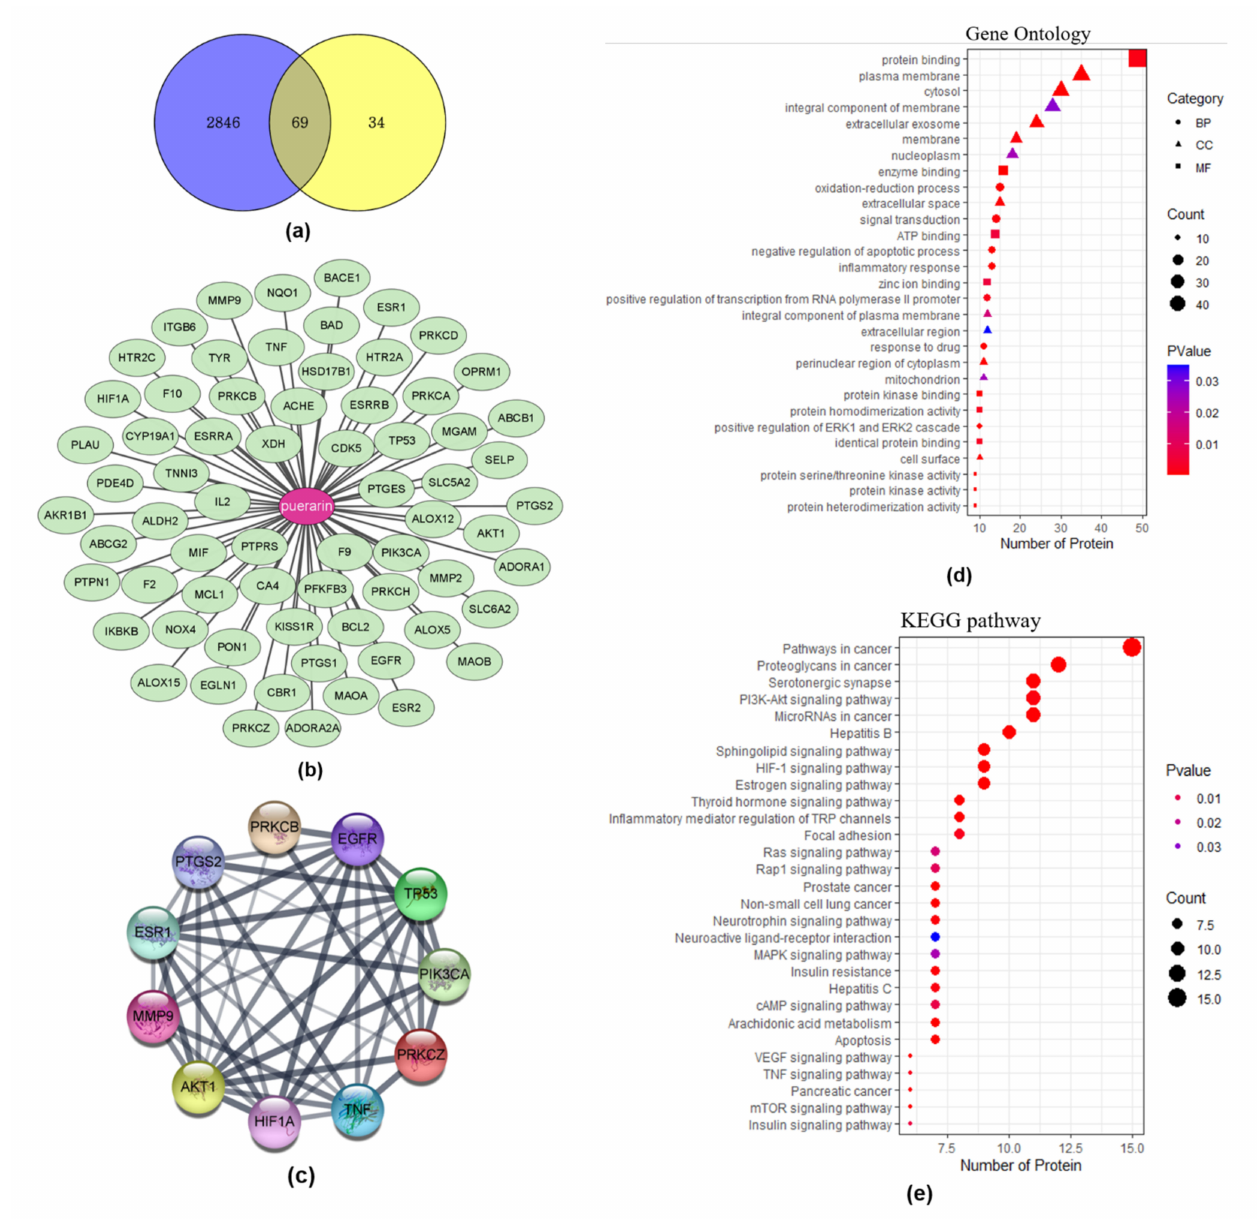
Figure 1. PPI network between hub genes of puerarin and obesity and functional pathway analysis. ( a ) Sixty-nine overlapping genes. ( b ) Ligand-target protein network. ( c ) Top 10 genes at high levels of connectivity. ( d ) GO enrichment analysis. ( e ) KEGG pathway analysis. PPI: Protein-protein interaction, GO: Gene ontology, KEGG: Kyoto Encyclopedia of Genes and